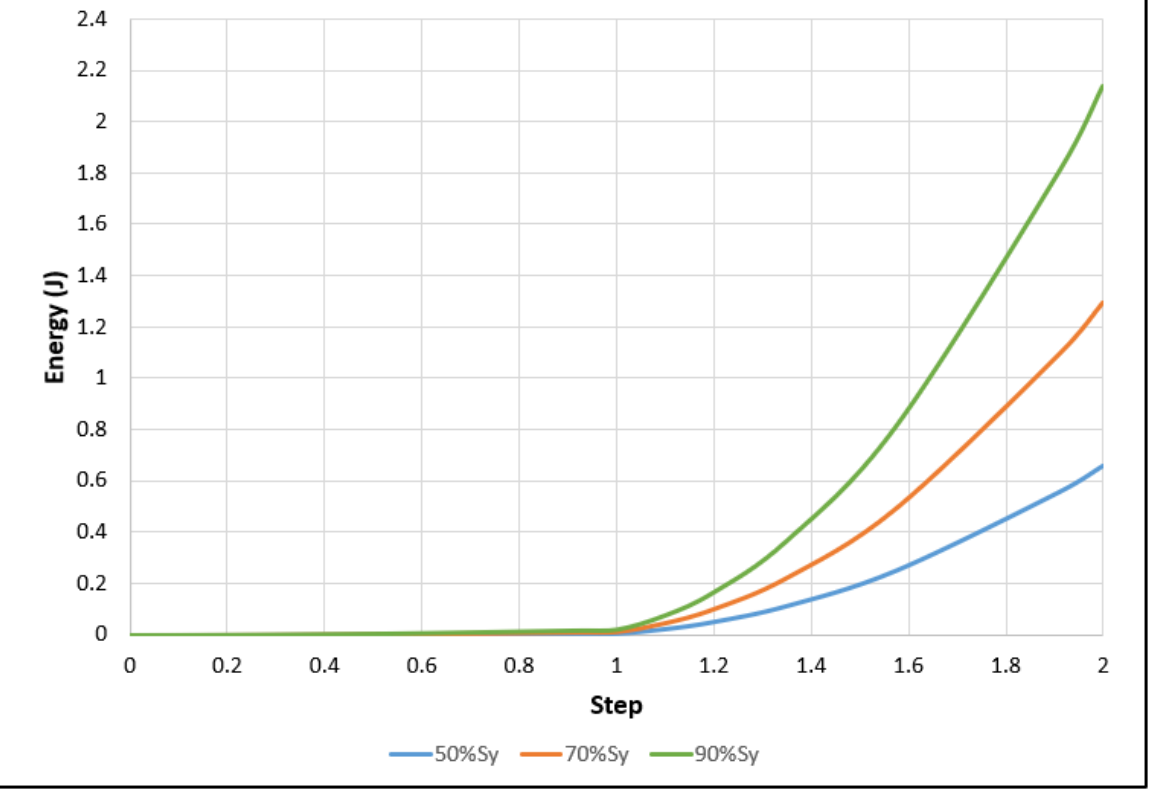
Figure 13. Absorbed energy (J) for a maximum nominal stress of 440.6 MPa (50% of the yield strength), 616.8 MPa (70% of the yield strength), and 793 MPa (90% of the yield strength).